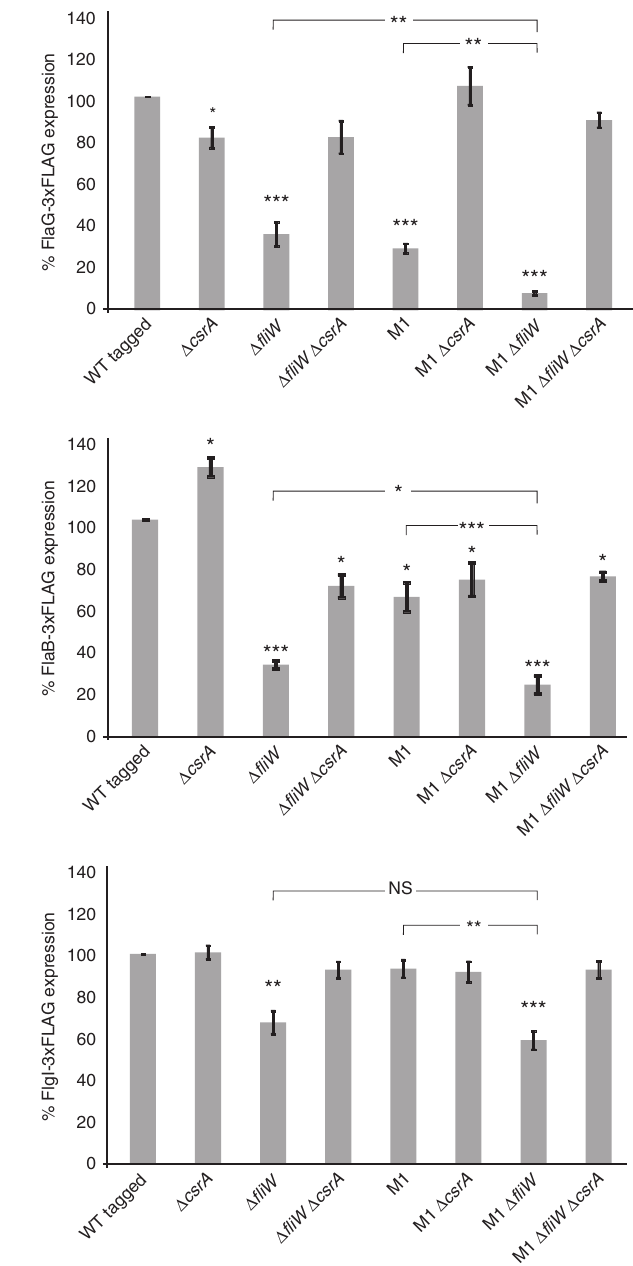
Figure 5 | The flaA 5 0 UTR and FliW inhibit CsrA-mediated regulation of flagella genes. Quantification of FlaG-3xFLAG, FlaB-3xFLAG and FlgI- 3xFLAG levels using western blot of the indicated C. jejuni NCTC11168 strains grown to mid-log phase (M1: GGA - AAA in SL1 of flaA 5 0 UTR). Values were calculated based on at least three biological replicates. Shown is the mean ± s.e.m (* P o 0.05, ** P o 0.01, *** P o 0.001, using Student’s t -test). NS, not